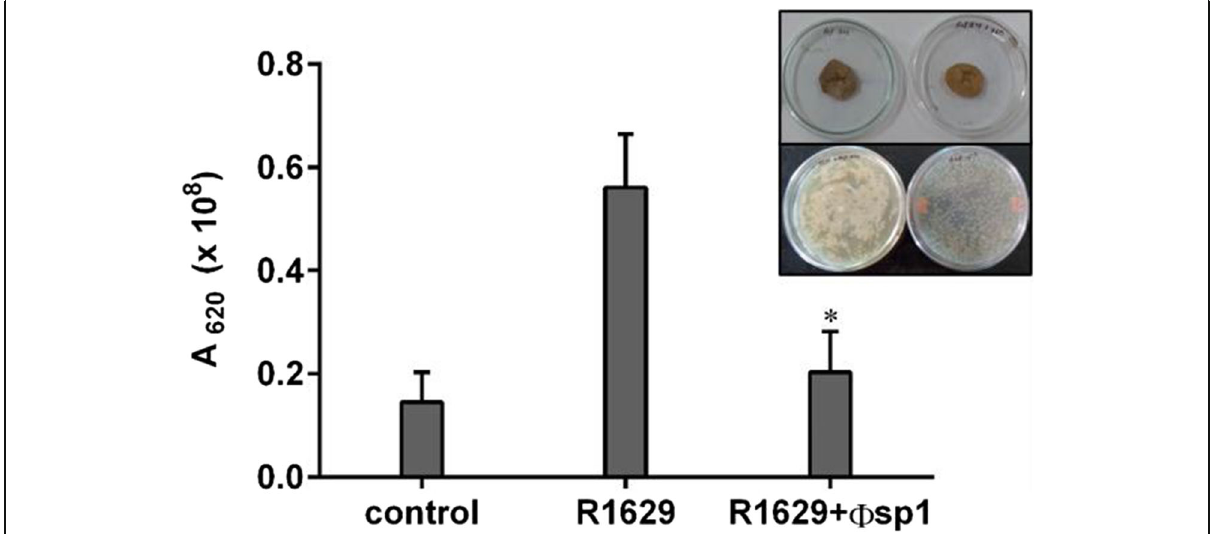
Fig. 5 Pathogenicity of Ralstonia solanacearum strain 1629 (R1629) and phage ɸ sp1 biocontrol efficacy on potato tuber slice. In vitro phage ɸ sp1 bioassay on potato tuber slices against R1629 and phage-untreated tuber. Plating of reisolated R1629 from phage ɸ sp1-treated R1629-infected potato tubers showing plaques on bacterial lawn. Standard plate count for R1629 from same potato tuber slices on TTC medium (figure inset). Reduction in R. solanacearum strain 1629 (R1629) following phage ɸ sp1 treatment in inoculated tuber sample suspension (0.1g/ml) post 10 days of inoculation. Phage ɸ sp1 + R1629 inoculated tuber slices show significantly reduced bacterial population compared to R1629 inoculated (* p ≤ 0.05). Growth measured with optical density (OD) by spectrophotometry absorbance at 620 nm (1.0 OD = 10 8